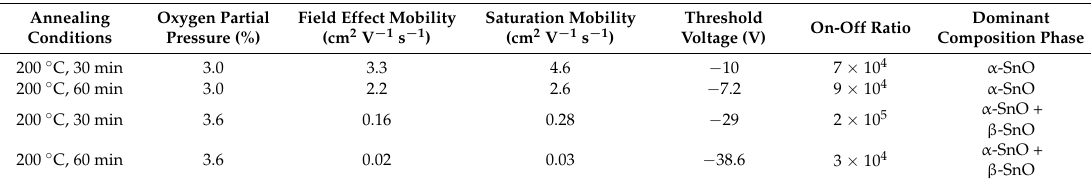
Table 4. Electrical properties of SnO x p-channel TFTs for different annealing time (channel thickness 12 nm). After annealing all structures are